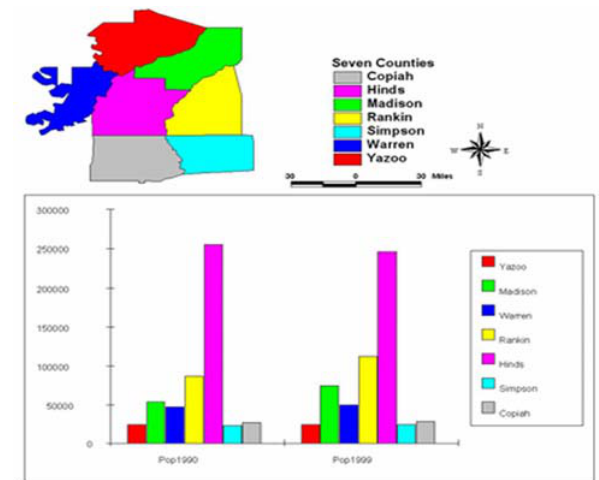
Figure 3.1: Population by County 1990